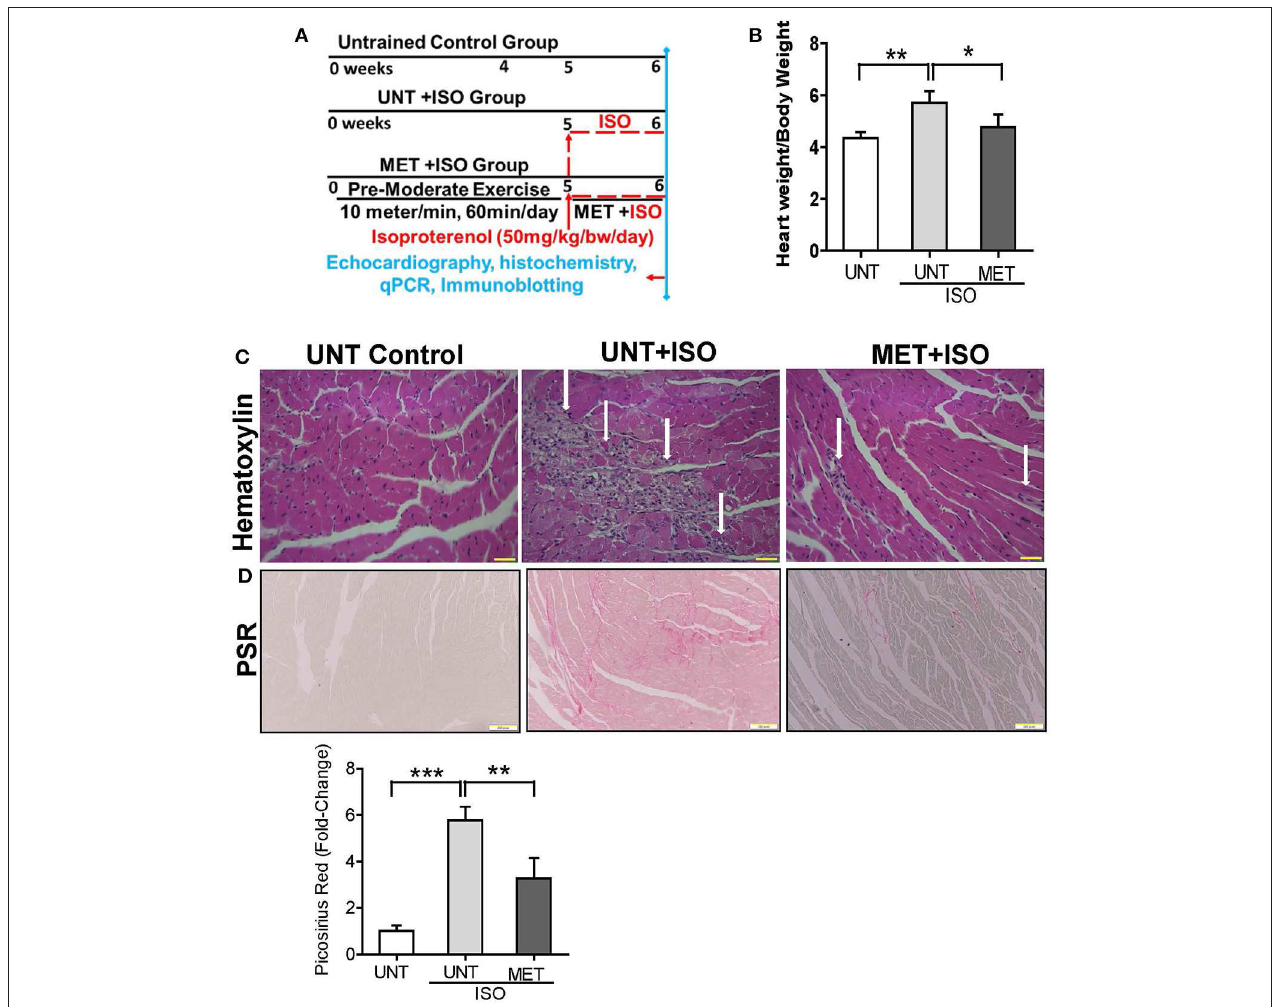
FIGURE 1 | Exercise protected the heart from Isoproterenol induced cardiac injury. (A) Schematic diagram explaining the exercise protocol and isoproterenol administration, (B) Graph illustrates the heart weight/bodyweight ratio in all groups ( n = 10/group), (C) Heart sections stained by hematoxylin eosin stain ( n = 6/group), (D) Picrosirius red stain was used to determine the collagen deposition in isoproterenol treated hearts using Olympus light microscope at 20X magnification. n = 3–4/group, values are represented as mean ± SD. Significance: * p < 0.05 ; ** p < 0.01 ; *** p <